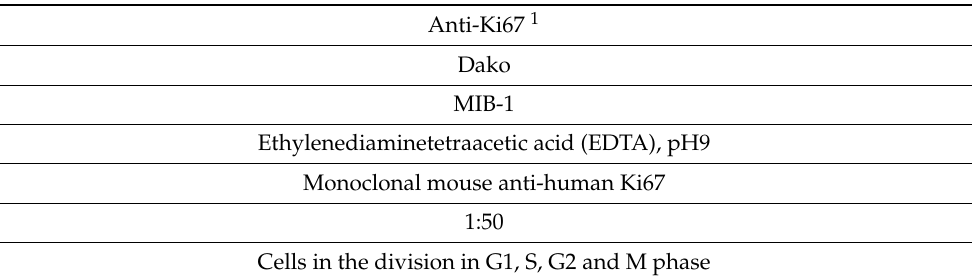
Table 1. The immunohistochemical panel of antibodies used for